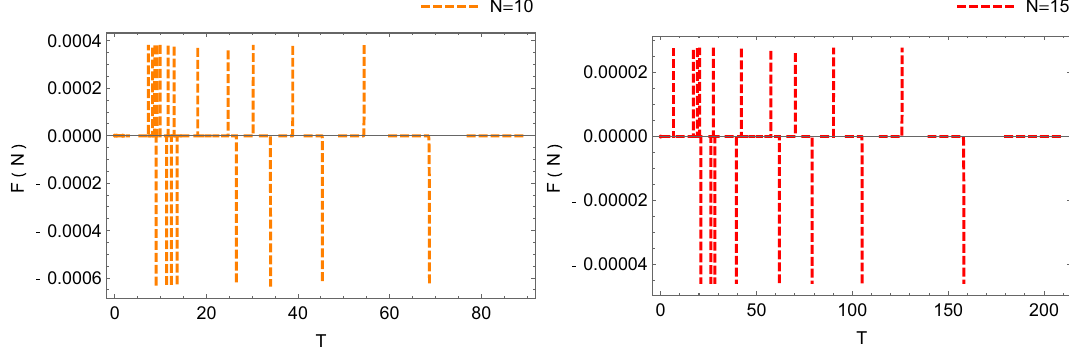
Fig. 7 Distribution function in terms of temperature with G = m = k = 1, and λ = 1 /